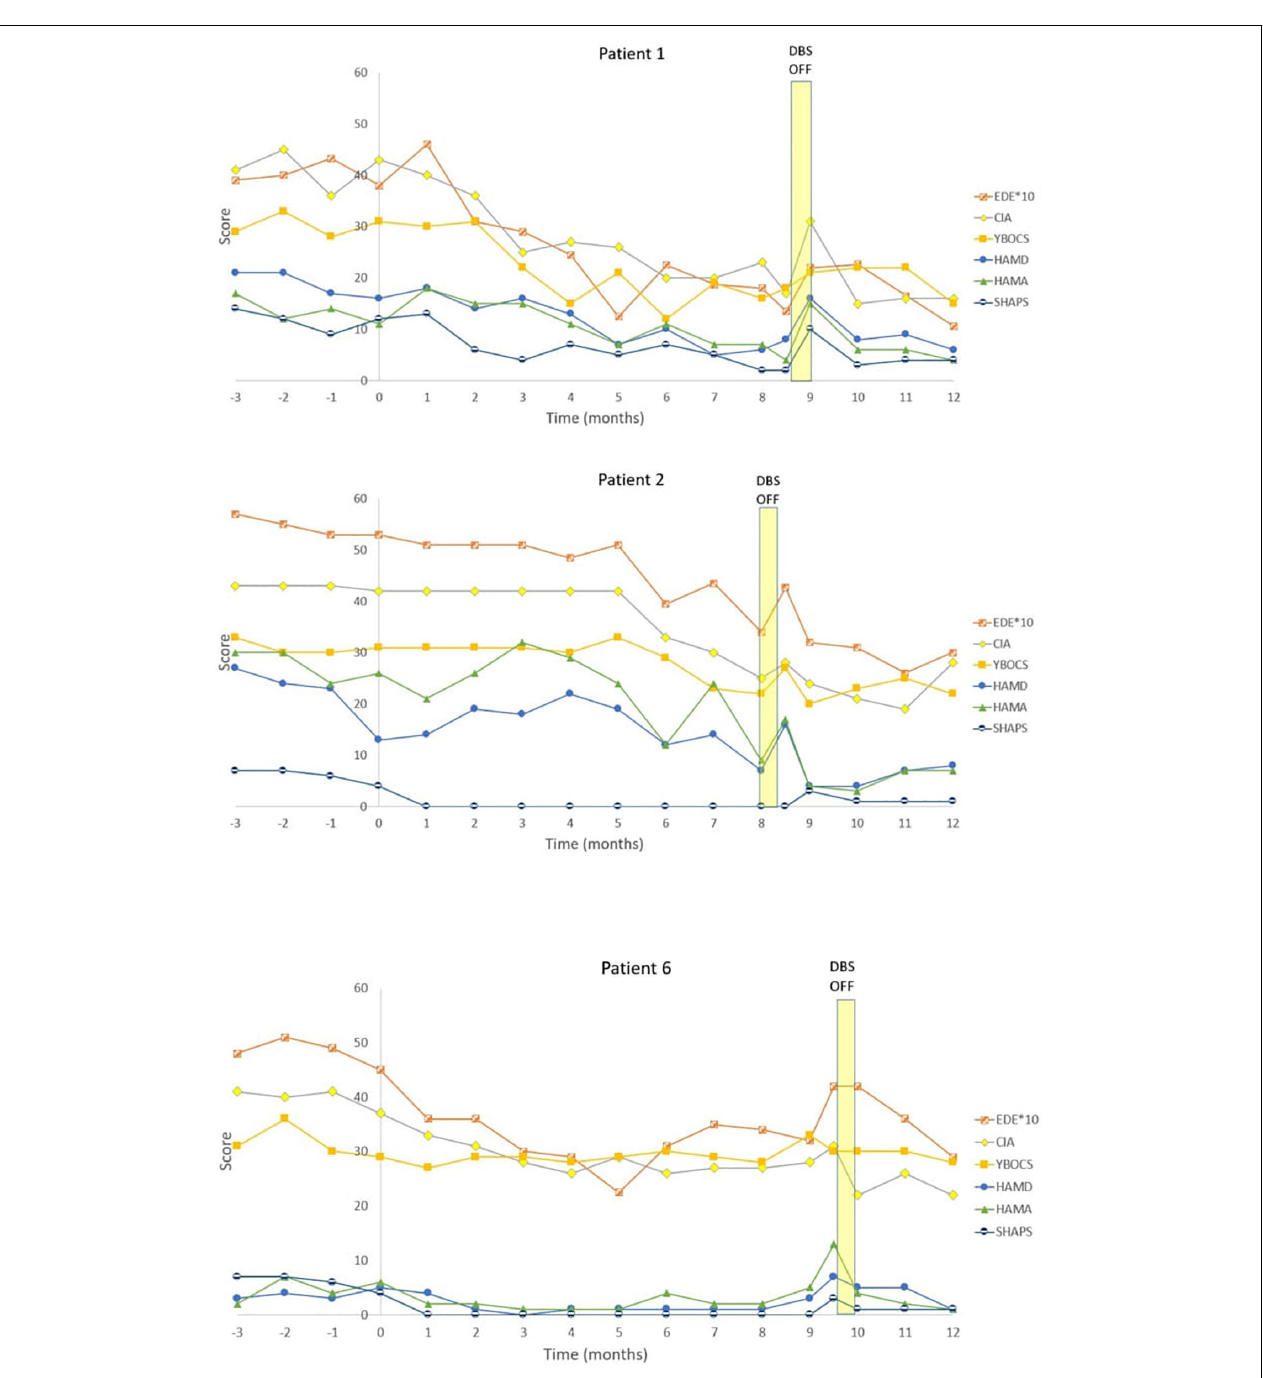
FIGURE 2 | Individual graphs for Responders: Patients 1, 2, 6. Eating Disorder Examination (EDE) X 10 for graphical purposes, Yale-Brown-Cornell Eating Disorder Scale (YBC_EDS), Hamilton Depression Scale (HAMD), Hamilton Anxiety Scale (HAMA), Snaith-Hamilton Pleasure Scale (SHAPS): Yale-Brown Obsessive-Compulsive Scale